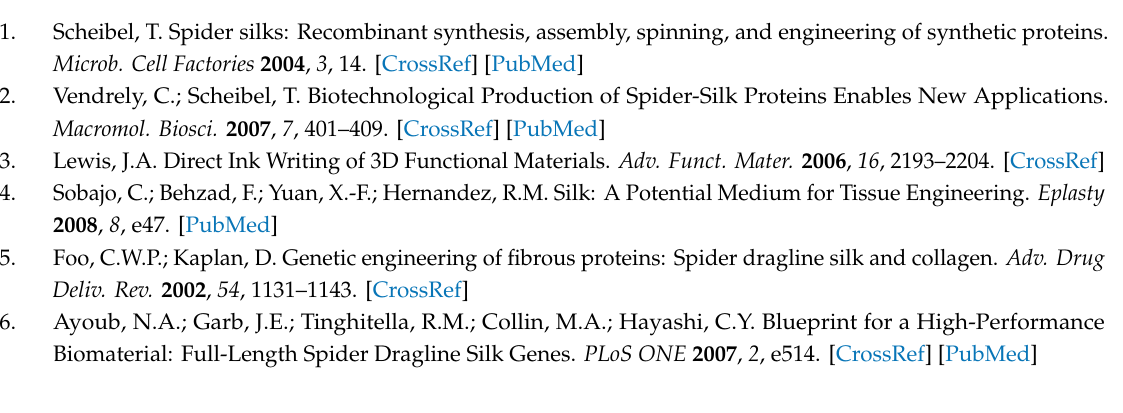
Supplementary Table S1. Composition of experimental diets; Supplementary Table S2. The body weight and liver weight. Supplementary Figure S1. Northern blot (A) and southern blot (B) analysis of AvMaSp overexpression in T0 transgenic rice; Supplementary Figure S2. SDS-PAGE of during the development of rice seeds and the transgenic